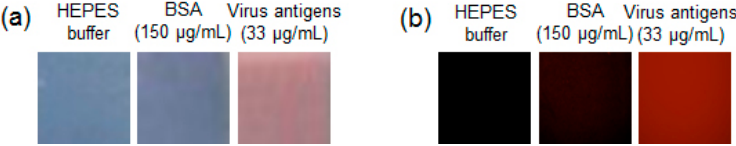
Figure 5. ( a ) Optical and ( b ) fluorescent microscopic images of the antibody-PDA functionalized polyvinylidene difluoride (PVDF) membranes.